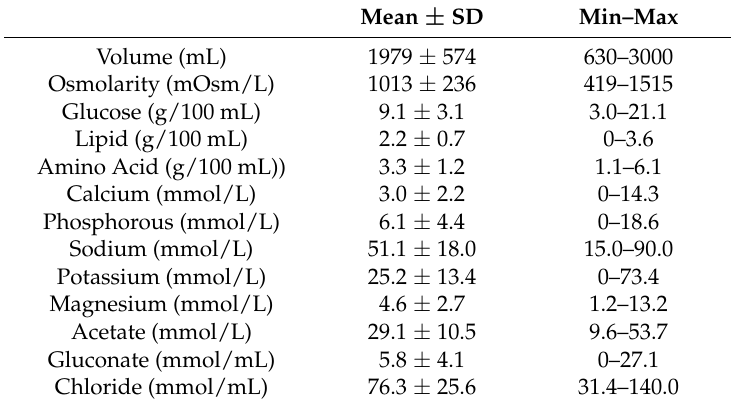
Table 1. Mean ± SD and minimum-maximum (min–max) values of the volume, osmolarity, and concentration of components in the compounded parenteral mixtures evaluated in thestudy ( n =